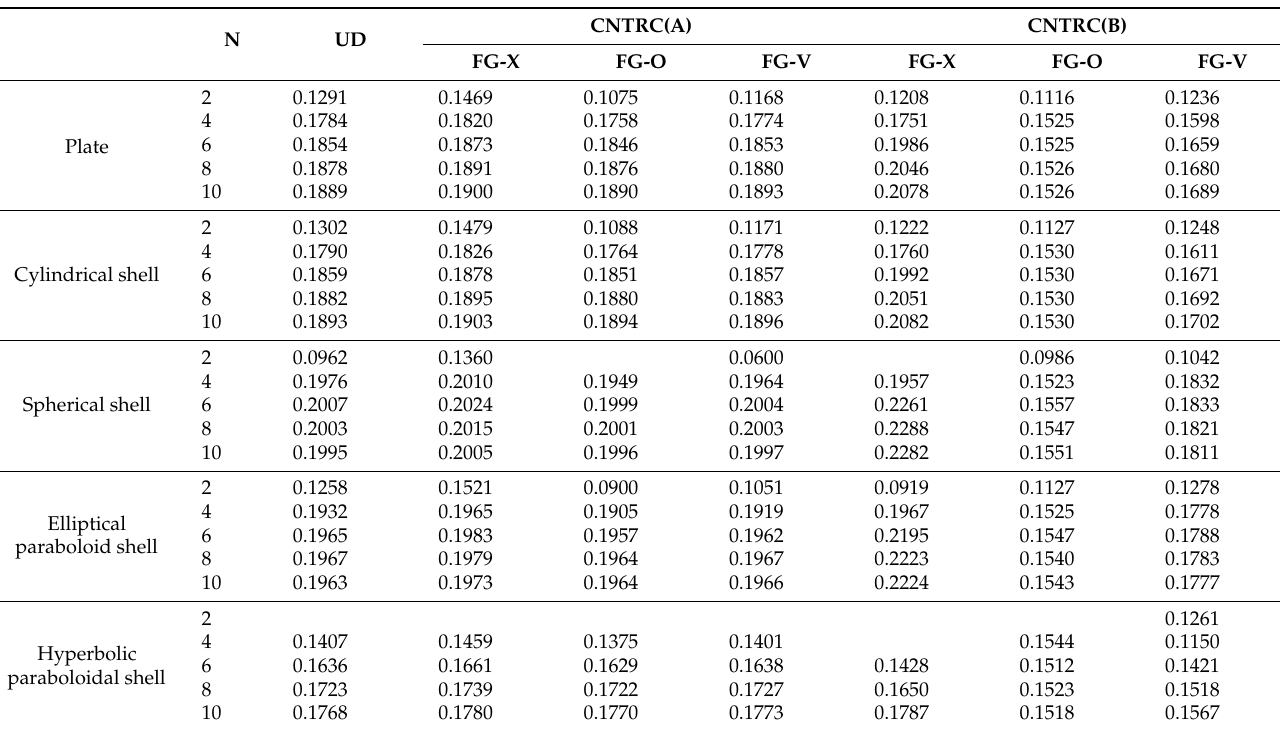
Table 4. Effect of CNTRC type and CNT distribution pattern on the dimensionless frequency of CNTRC shells for various number of layers N (SSSS, p = 1, b / a = 1, a / h = 10, V cnt = 0.17, T = 300 K ).